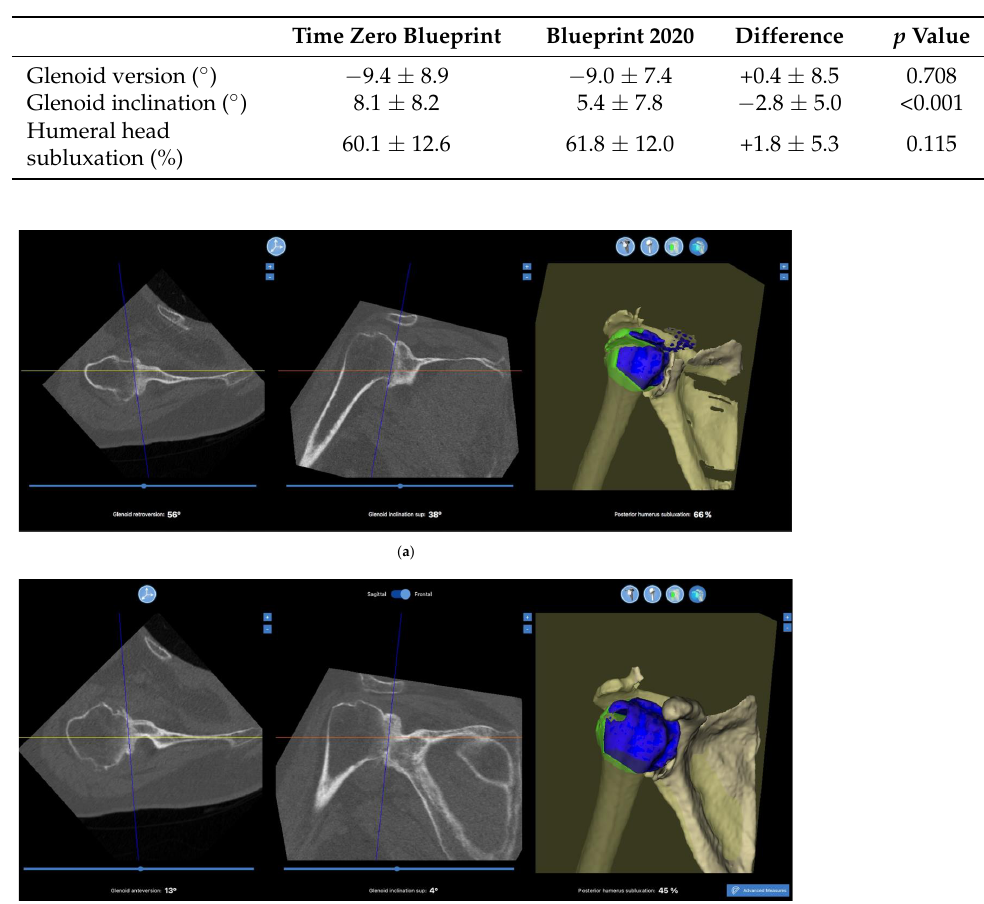
Table 2. Glenoid and joint alignment measurements achieved with Time Zero Blueprint and Blueprint 2020. Values are represented as mean with standard deviation.